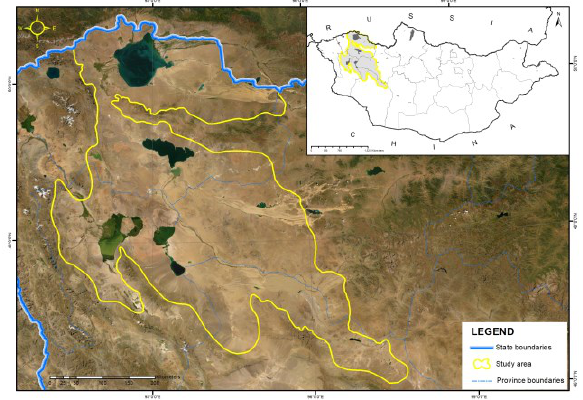
Figure 1 . Location map of study